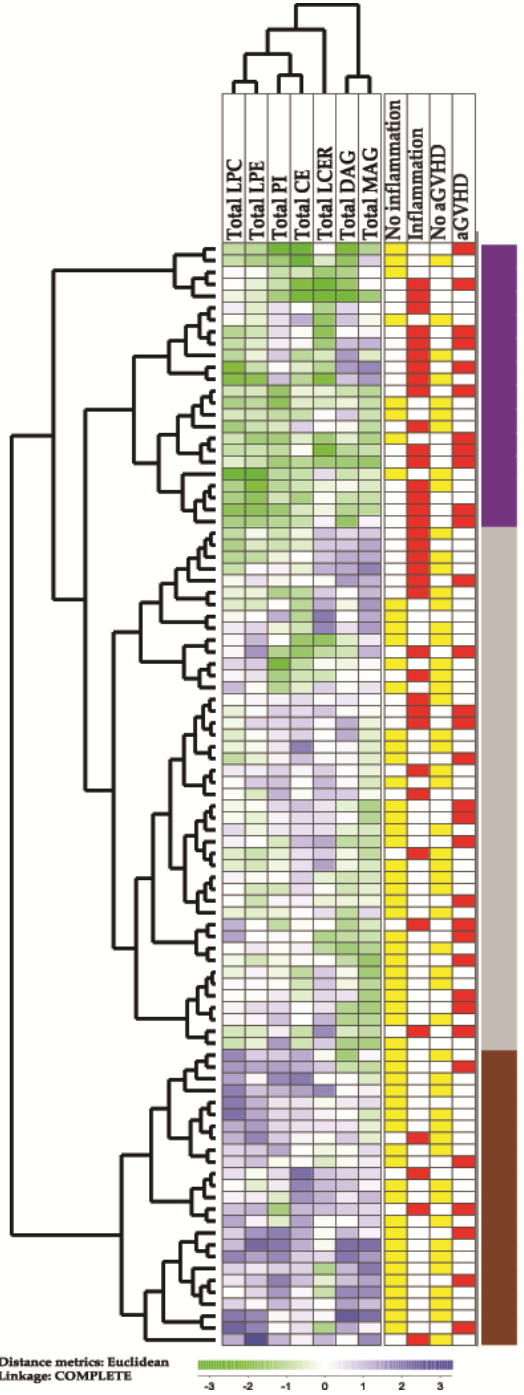
Figure 1. An unsupervised hierarchical cluster analysis based on the total concentrations of lipid metabolites in pretransplant serum samples derived from 93 allogeneic stem cell transplant recipi- ents. In this analysis, we included the total serum concentrations of lysophophatidylcholine (LPC), lysophosphatodylethanolamine (LPE), phosphatidylinositol (PI), cholesteryl esters (CE), sphin- golipid/lactosylceramide (LCER), diacylglycerols (DAG) and monoacylglycerols (MAG); the lipid levels were significantly altered when comparing recipients with and without signs of inflammation and/or patients with and without later acute GVHD grade 2–4. Green indicates low levels, while purple indicates high levels of metabolites for individual patients. The column to the far right indicates the three patient subsets identified by clustering, showing varied levels of